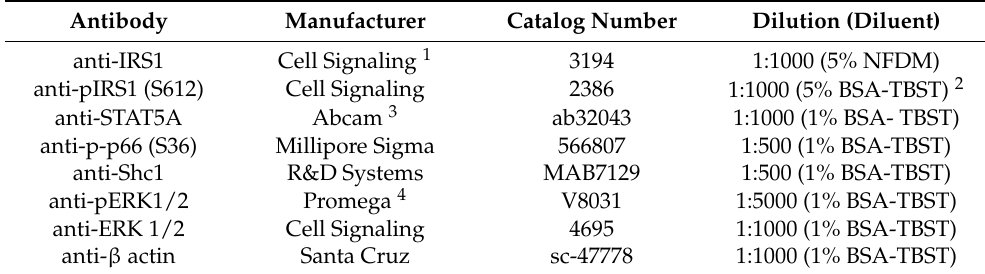
Table 1. Primary antibodies used for